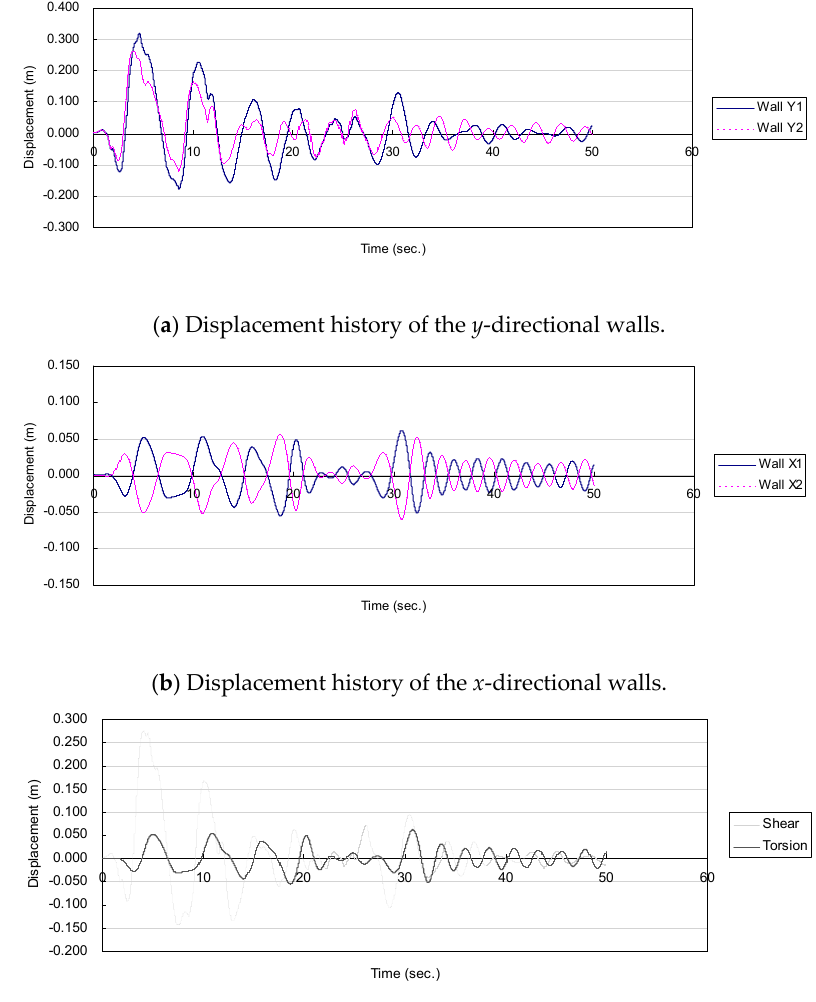
( c ) Displacement components of Wall Y 1 induced by the lateral force and torsional moment. Figure 15. Lateral displacement history of each wall component (El Centro, α = 1.3, β = 1.0).